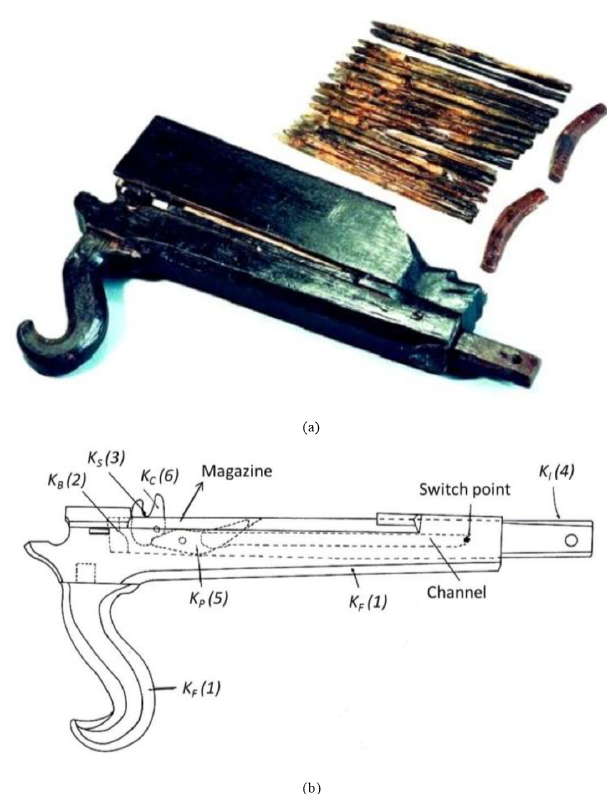
Figure 5. Chu State repeating